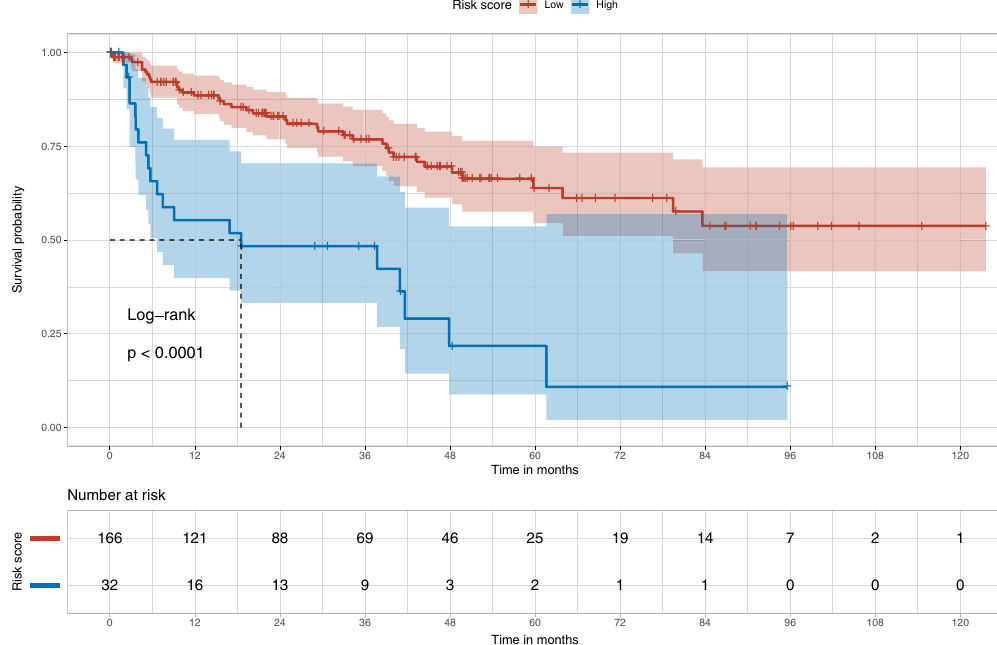
Figure 6. Kaplan–Meier plots for the high- and low-risk subgroups in the external (Stanford-HCC) test set. The Kaplan–Meier plot shows the difference in the survival distributions for the low- and high-risk subgroups, stratified based on the risk scores predicted by HCC-SurvNet on the external test set (log-rank p value < 0.0001).